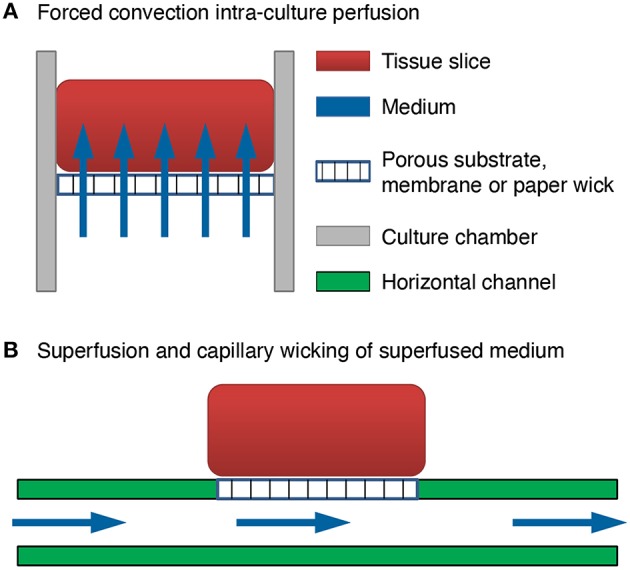
Comparison of brain slice perfusion methods. (A) Forced convection intra-culture perfusion. The flow of equilibrated medium is forced to pass through the mass of cells and through the full culture thickness. (B) Superfusion and capillary wicking of superfused medium by the tissue slice. The flow of equilibrated medium is not forced to pass through the mass of cells and through the full culture thickness. The resistance to fluid flow through the culture thickness is much higher than the resistance to fluid flow in a channel below the tissue. Flow passes through the channel and the tissue slice wicks the medium from the channel by capillarity.